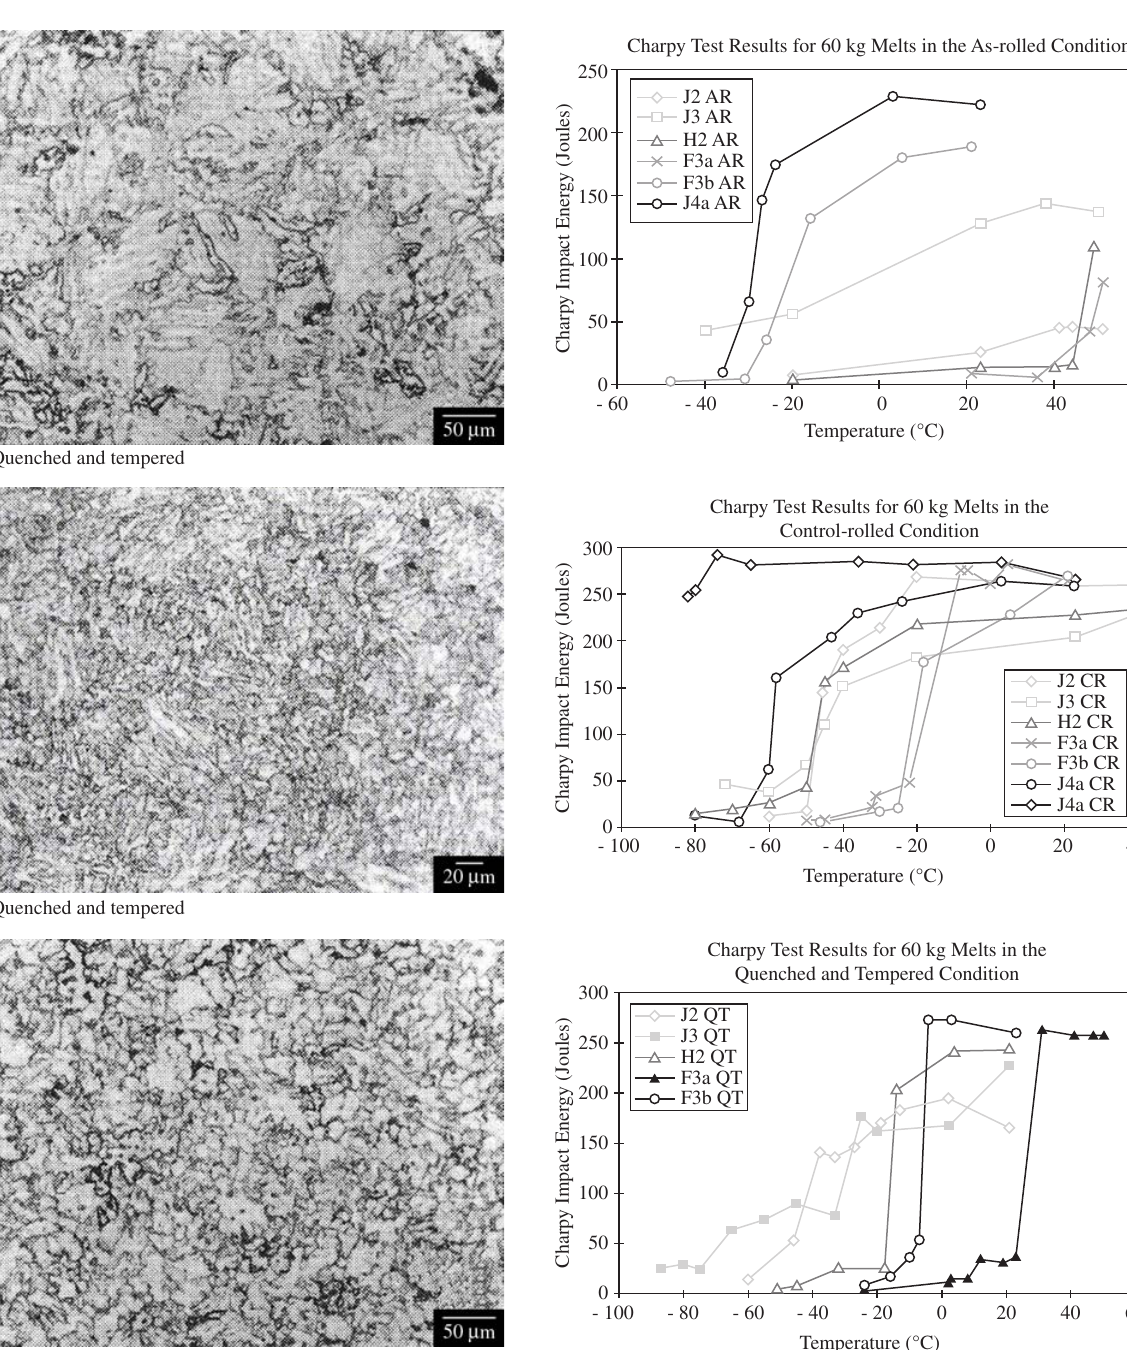
Figure 8. Light micrographs illustrating the microstructures of a selection of the experimental steels.